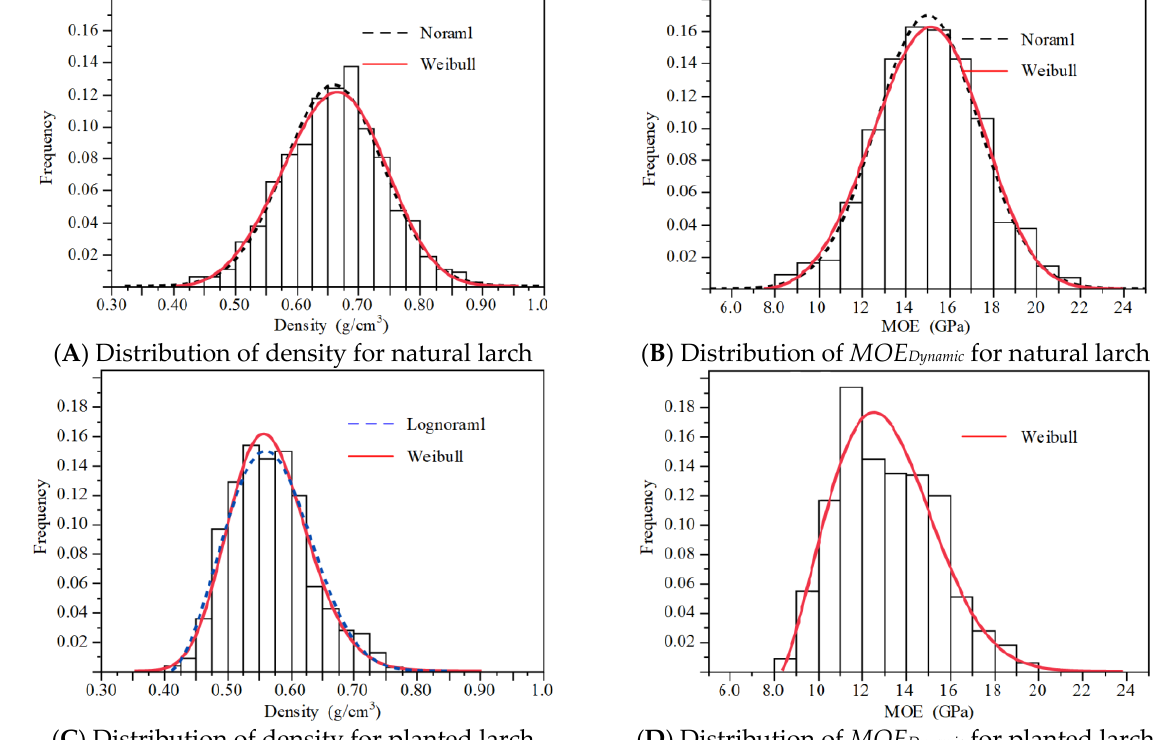
Figure 7. Distribution histograms and fitting curves of larch lumber MOE.